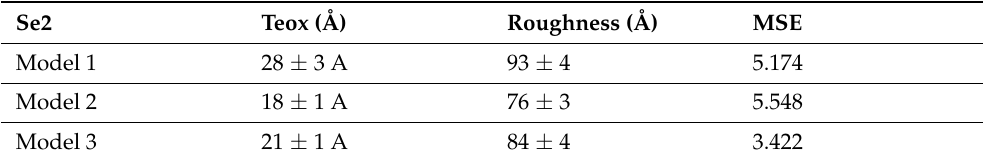
Table 1. Ellipsometry fit parameters obtained for the sample Se2 with the different models proposed in Figure 1.